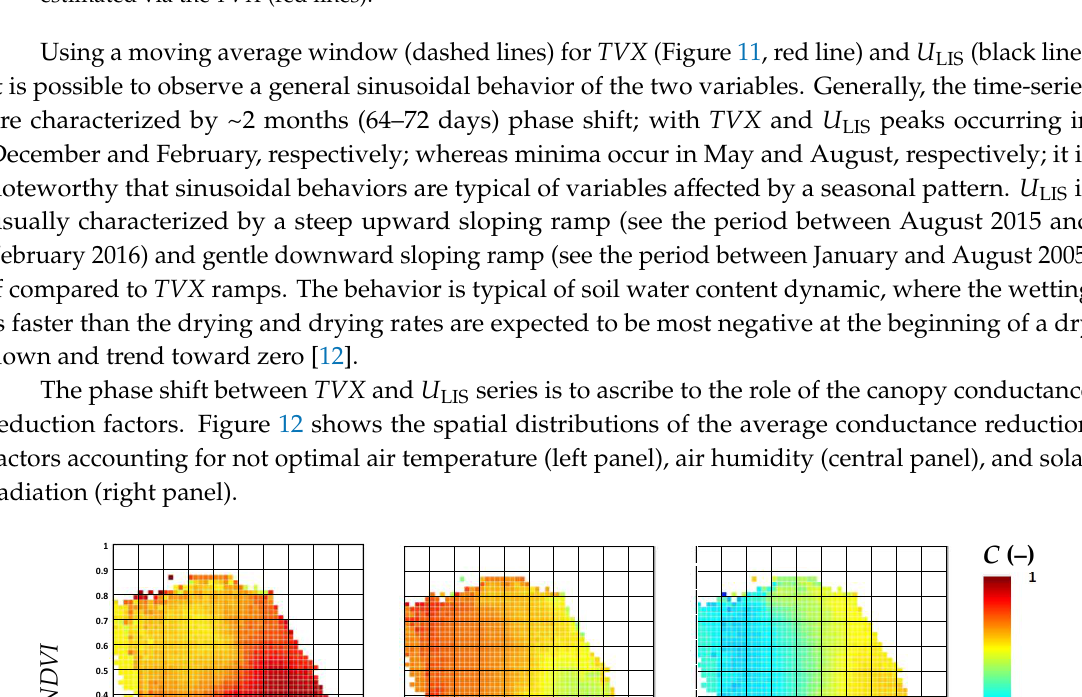
Figure 11. Soil water content modeled via LISFLOOD ( U LIS , black lines) vs. soil water content index estimated via the TVX (red lines).